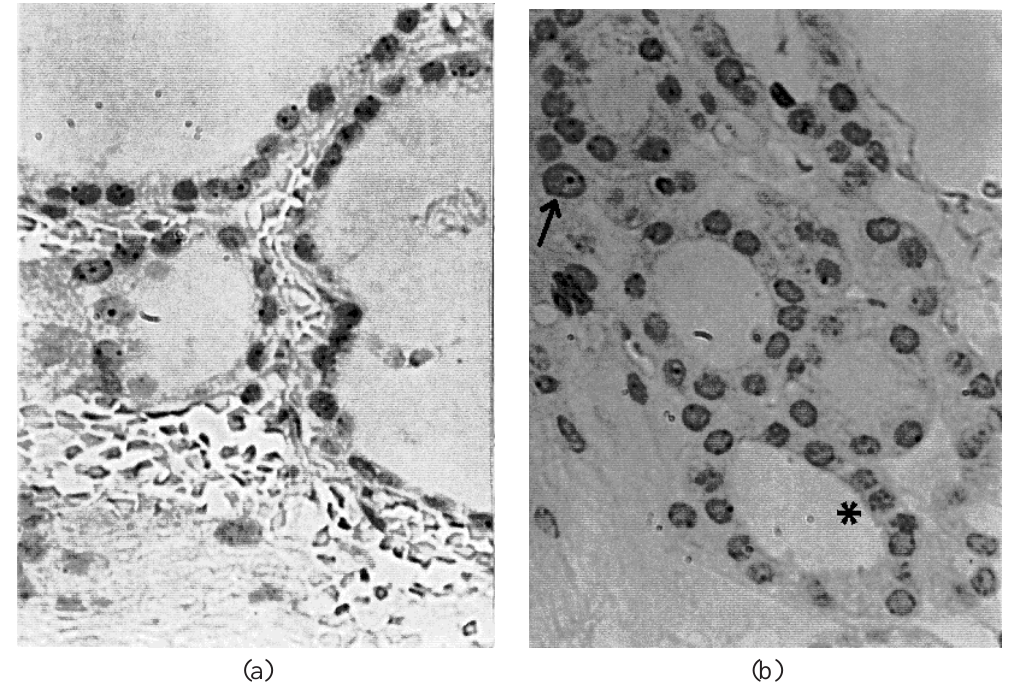
Fig. 5. (a) In situ hybridization of a nodular colloid goiter (NCG case no. 9) with chromosome 1 probe, showing two trisomic cells. (b) In situ hybridization of the AAI case no. 43 with chromosome 17 probe, that showed big, clear cells with two signals (arrow) and small cells with four signals